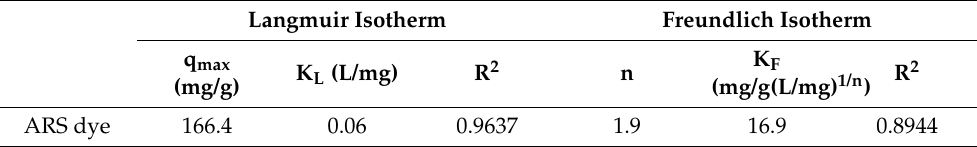
Table 1. Langmuir and Freundlich isotherm parameters for ARS dye adsorption onto the MCN .